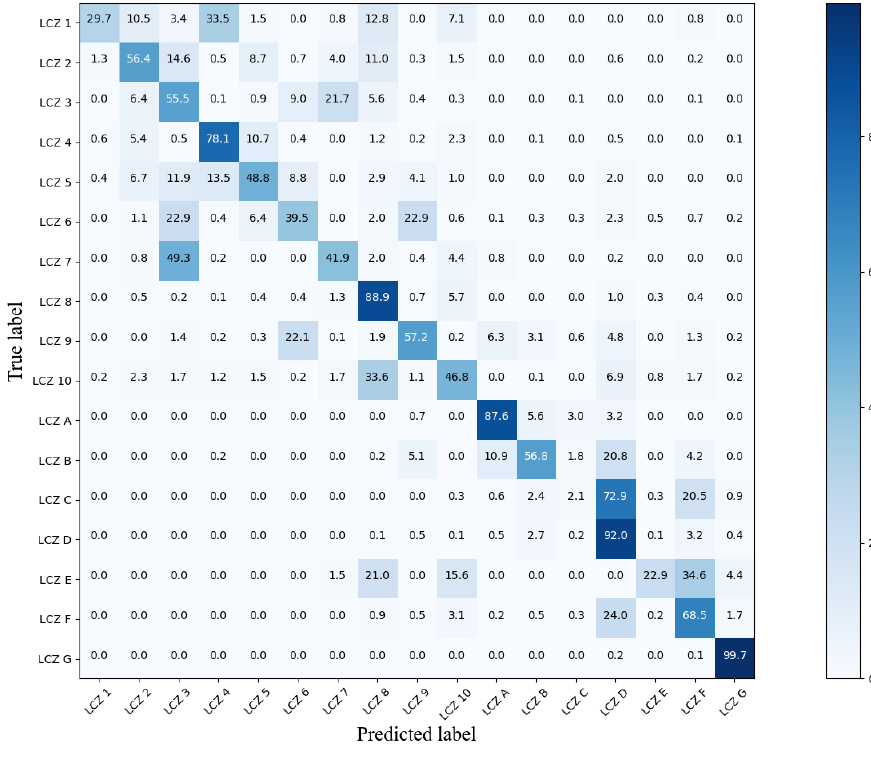
Figure 7. Confusion matrix of classification results from MsF-LCZ-Net (N = 5). For ease of presenta- tion, the results are normalized by one percent of the total number of samples in each LCZ